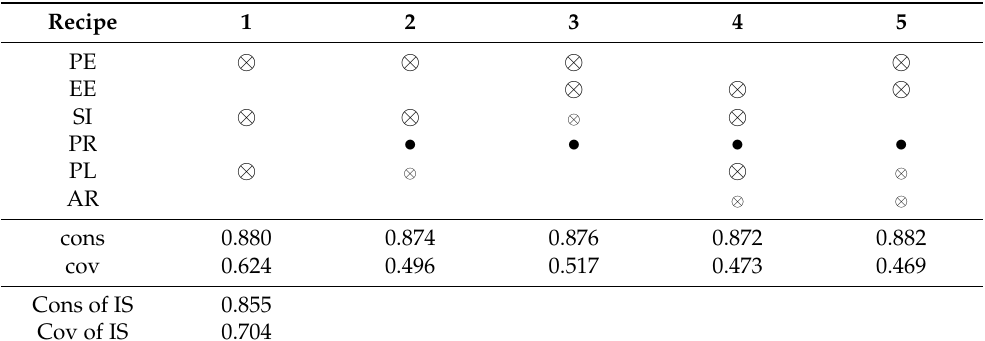
Table 6. fsQCA intermediate solution ~ACCEPT = f (PE, EE, SI, PR, PL,